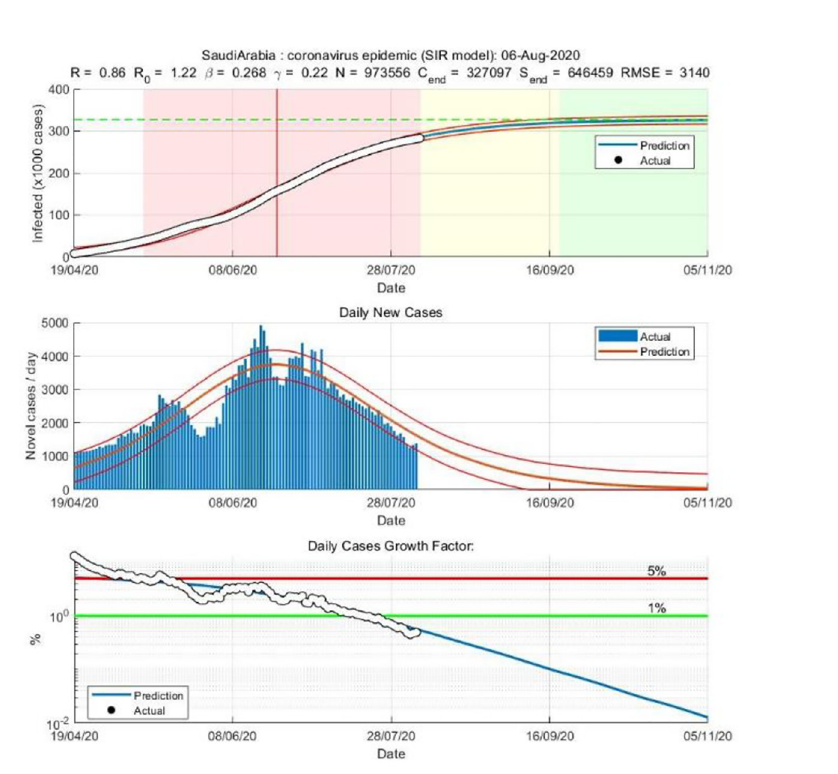
Fig 3. SIR model based on post-lockdown data (until Aug 5, 2020).